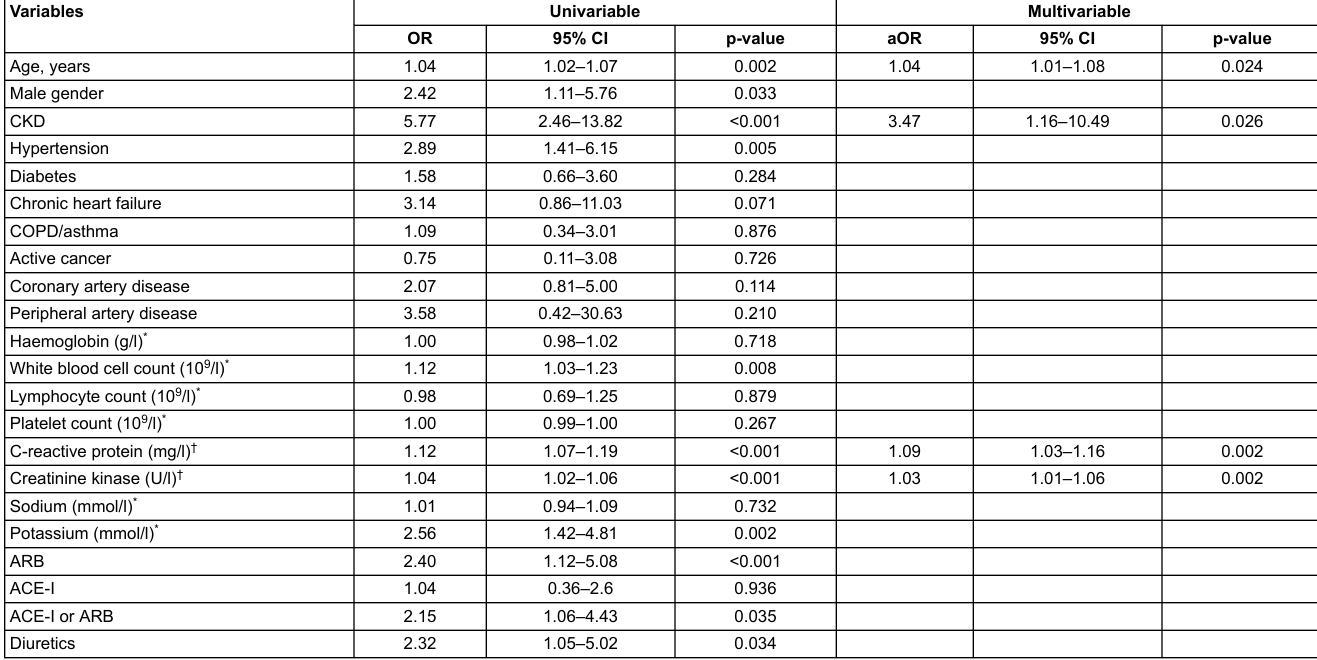
Table 2: Univariable and multivariable logistic regression analysis.